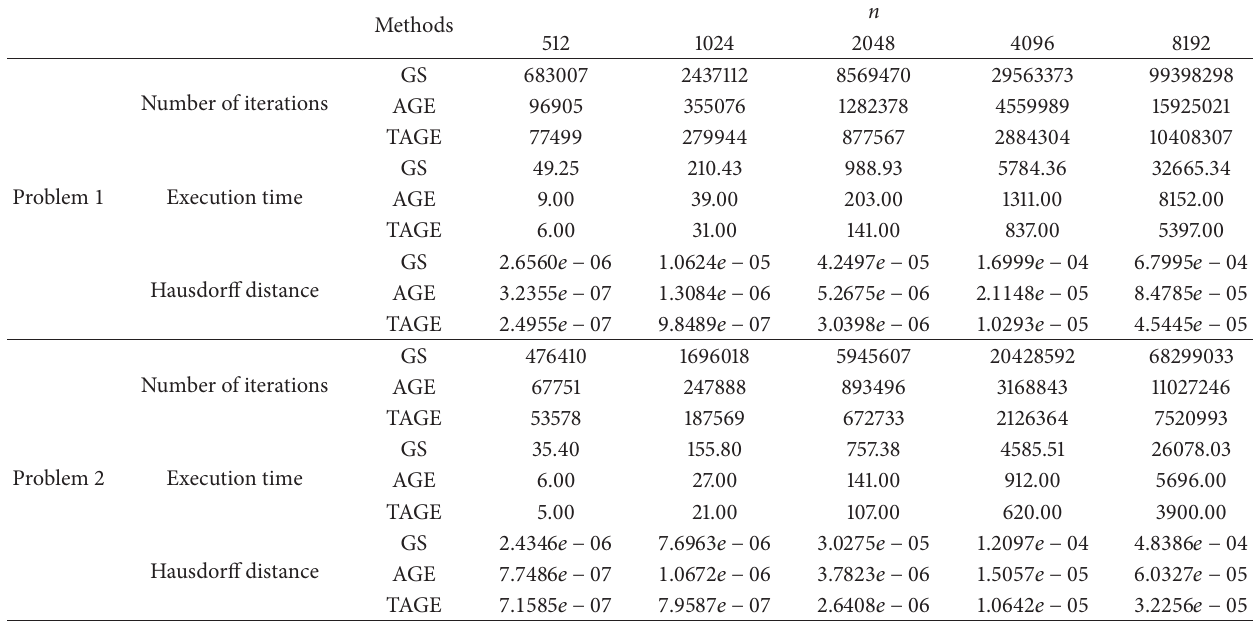
Table 3: Comparison of three parameters between GS, AGE, and TAGE methods at 𝛼 = 0 . 50.